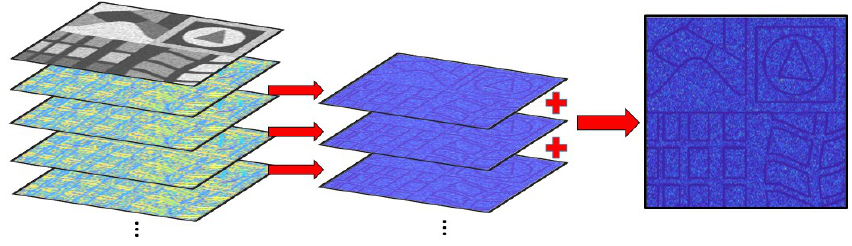
Figure 4. Direction-difference map generation